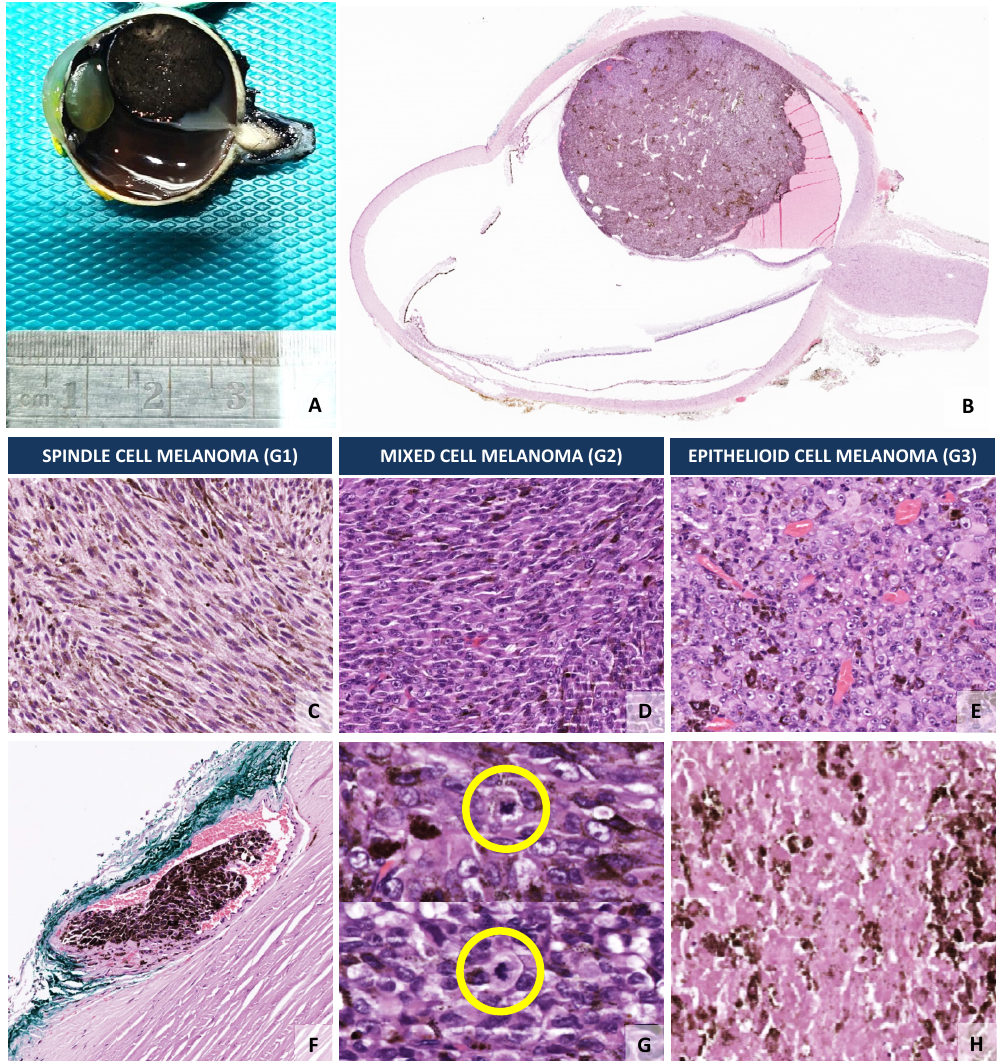
Figure 2. Uveal melanoma is a primary malignant tumour of the eye with a potential dismal prognosis, since nearly 50% of the patients die because of metastases, preferentially to the liver, Figure 2. Lamas et al. , 2021 which are not curable due to the absence of meaningful therapeutic strategies. The morphological features of uveal melanoma are instrumental to predict the prognosis of patients. ( A ) Eye specimen containing a pigmented round tumour located in the choroid (posterior segment of the eye), the most frequent anatomic location of uveal melanomas. ( B ) Whole-slide representative microscopic view of the large-sized choroidal melanoma with evidence of associated exudative retinal detachment (H&E, 2 × magnification). ( C ) Uveal melanomas composed by more than 90% of spindle cells are called spindle cell melanomas (G1; H&E, 400 × magnification). ( D ) Uveal melanomas containing more than 10% of a spindle cell component and less than 90% of an epithelioid component are termed mixed cell melanomas (G2; H&E, 400 × magnification). ( E ) Epithelioid cell melanomas (G3), which are associated with a worse patient prognosis, are composed by more than 90% of epithelioid malignant cells (H&E, 400 × magnification). ( F ) Uveal melanoma disseminates systemically through a preferential haematogenous pathway. The presence of images of vascular invasion is correlated with a worse prognosis for patients (H&E, 200 × magnification). ( G ) The presence of an increased number of mitosis (yellow circle) also hints a worse outcome for uveal melanoma patients (H&E, 200 ×